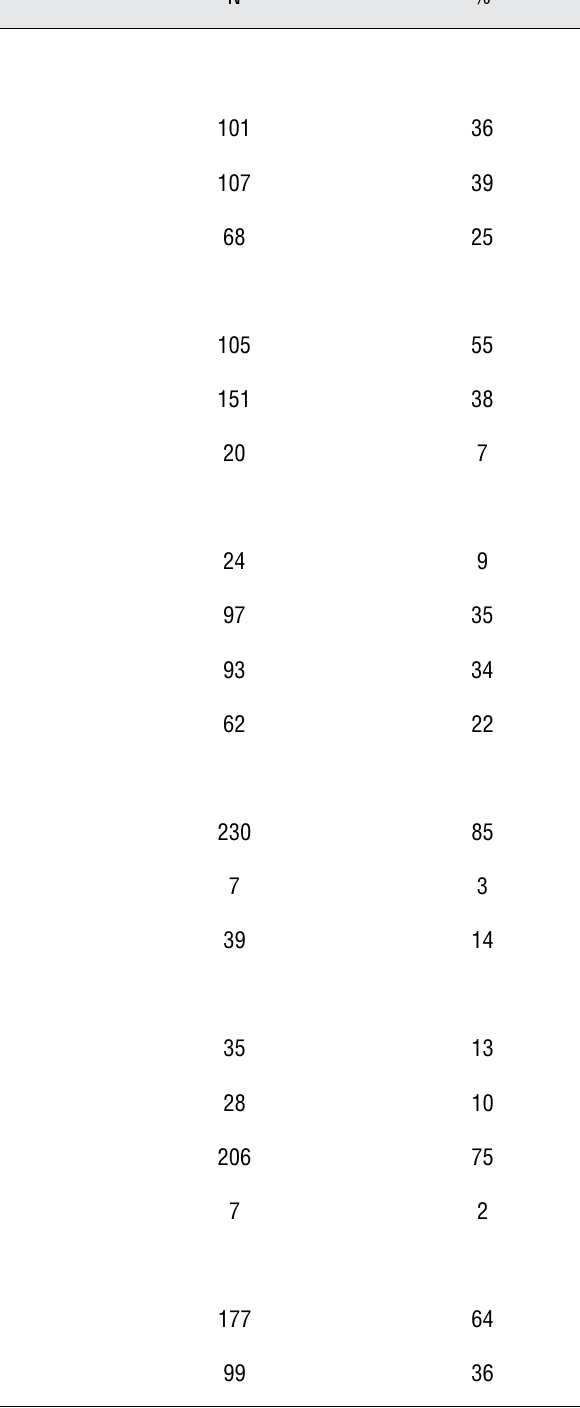
Table 2 - Distribution of sexual behavior variables, use of condoms and previous STDs of 276 HIV+/AIDS males. Variables N % Sexual